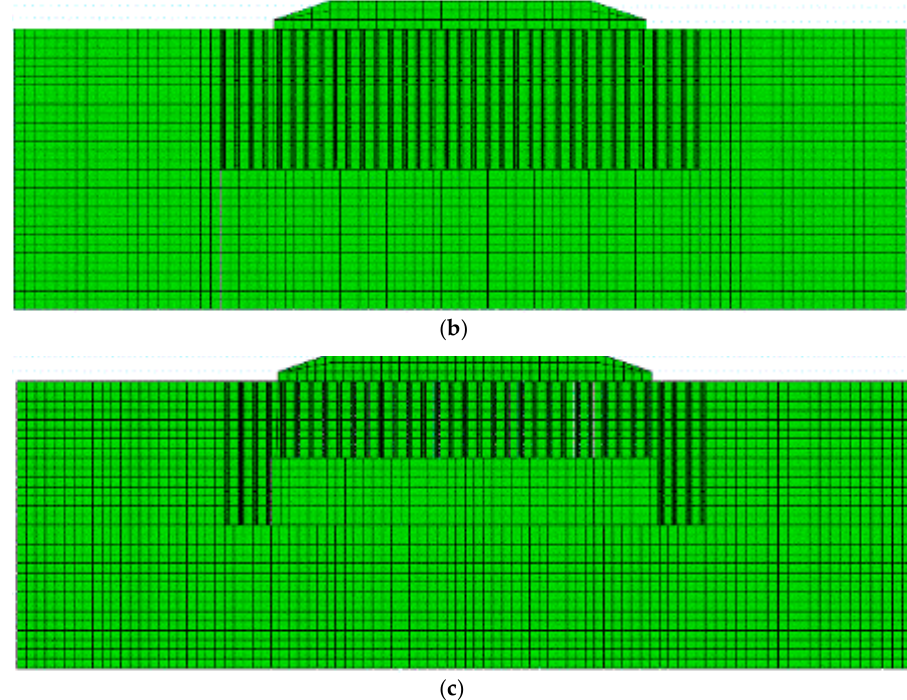
Figure 6. Finite element models of the natural foundation and foundations with the two studied reinforcement schemes. ( a ) Natural foundation. ( b ) Foundation with isometric gravel piles scheme. ( c ) Foundation with subarea long-short gravel piles scheme.